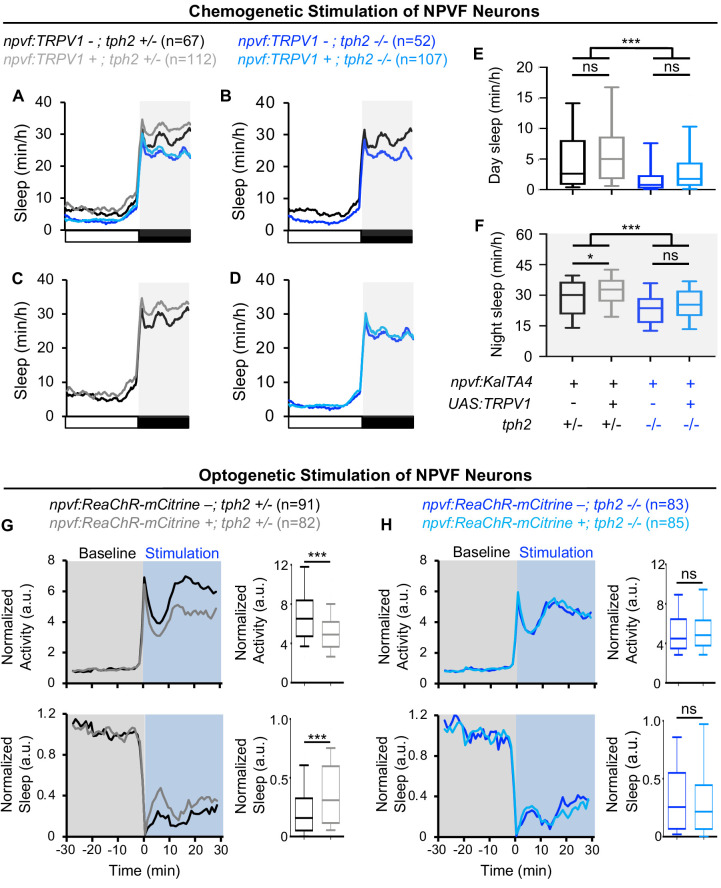
Sleep induced by chemogenetic or optogenetic stimulation of NPVF neurons is abolished in tph2 mutant animals.(A) Sleep of 5-dpf Tg(npvf:KalTA4); tph2+/- (black), Tg(npvf:KalTA4); tph2-/- (dark blue), Tg(npvf:KalTA4); Tg(UAS:TRPV1-TagRFP-T); tph2+/- (gray), and Tg(npvf:KalTA4); Tg(UAS:TRPV1-TagRFP-T); tph2-/- (light blue) siblings treated with 2 μM Csn. White and black bars under behavioral traces indicate day and night, respectively. (E,F) Box plots quantify sleep during the day (E) and night (F). Chemogenetic stimulation of NPVF neurons increases sleep at night compared to non-transgenic sibling controls in tph2+/- animals (C,F) but not in tph2-/- siblings (D,F). n = number of animals. ns p>0.05, *p<0.05, ***p<0.005, Two-way ANOVA with Holm-Sidak test. (G,H) Normalized locomotor activity (top) and sleep (bottom) of Tg(npvf:ReaChR-mCitrine) (gray and light blue) and non-transgenic sibling control (black and dark blue) animals before (Baseline) and during exposure to blue light (Stimulation) in (G) tph2+/- or (H) tph2-/- animals. Box plots quantify locomotor activity and sleep for each animal during optogenetic stimulation normalized to the baseline of all animals with the same genotype. Optogenetic stimulation of NPVF neurons decreases locomotor activity and increases sleep compared to non-transgenic sibling controls in tph2+/- animals (G) but not in tph2-/- siblings (H). n = number of animals. ns p>0.05, ***p<0.005, Mann-Whitney test.